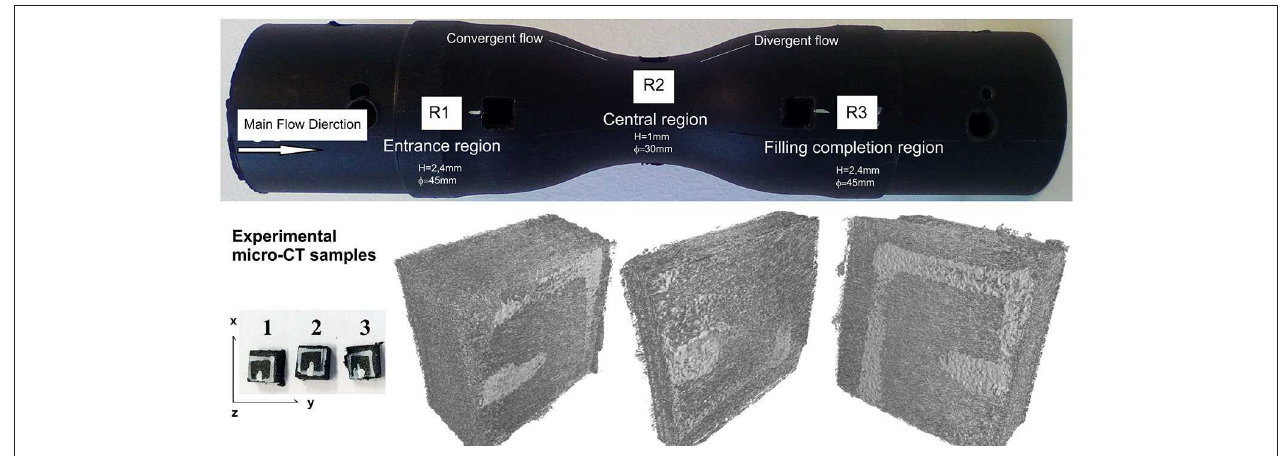
FIGURE 1 | Specimen, regions of interest and micro-CT samples.